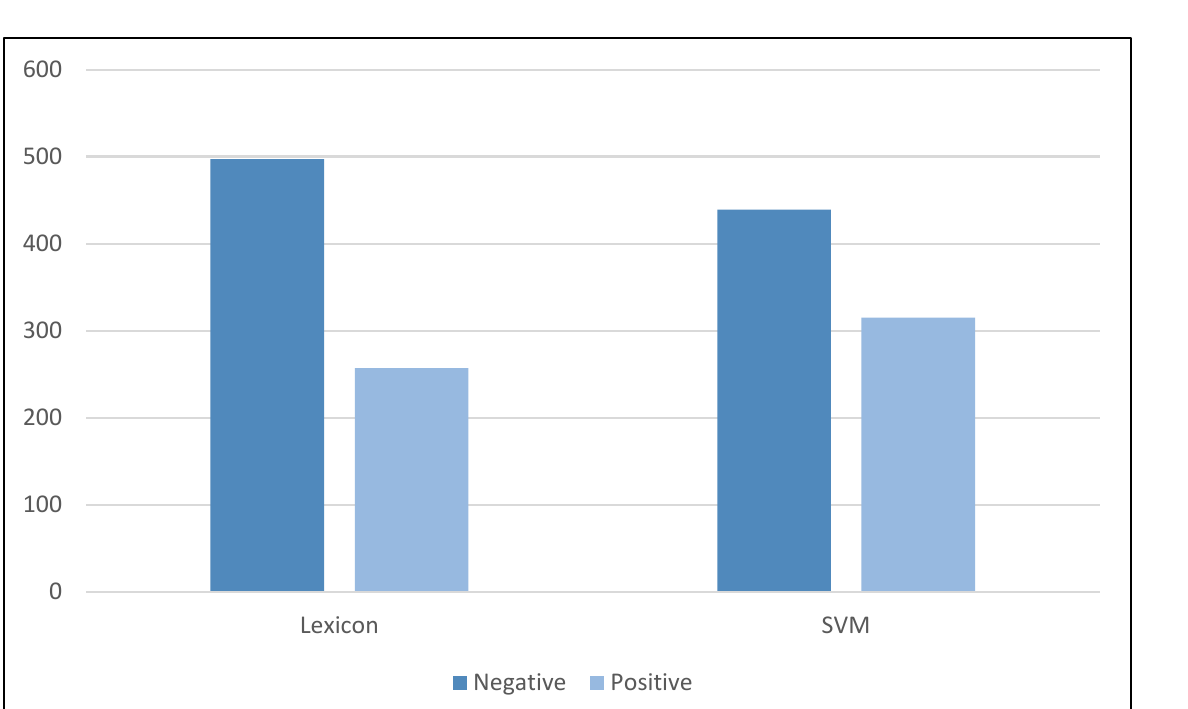
Figure 12. Comparison of polarity score chart.